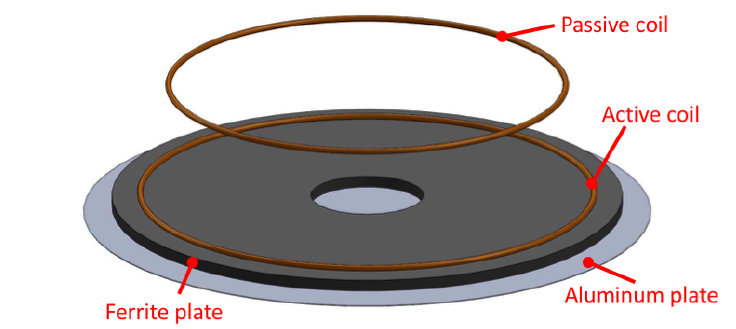
Figure A1. 3D view of the axisymmetric model for magnetic simulation.